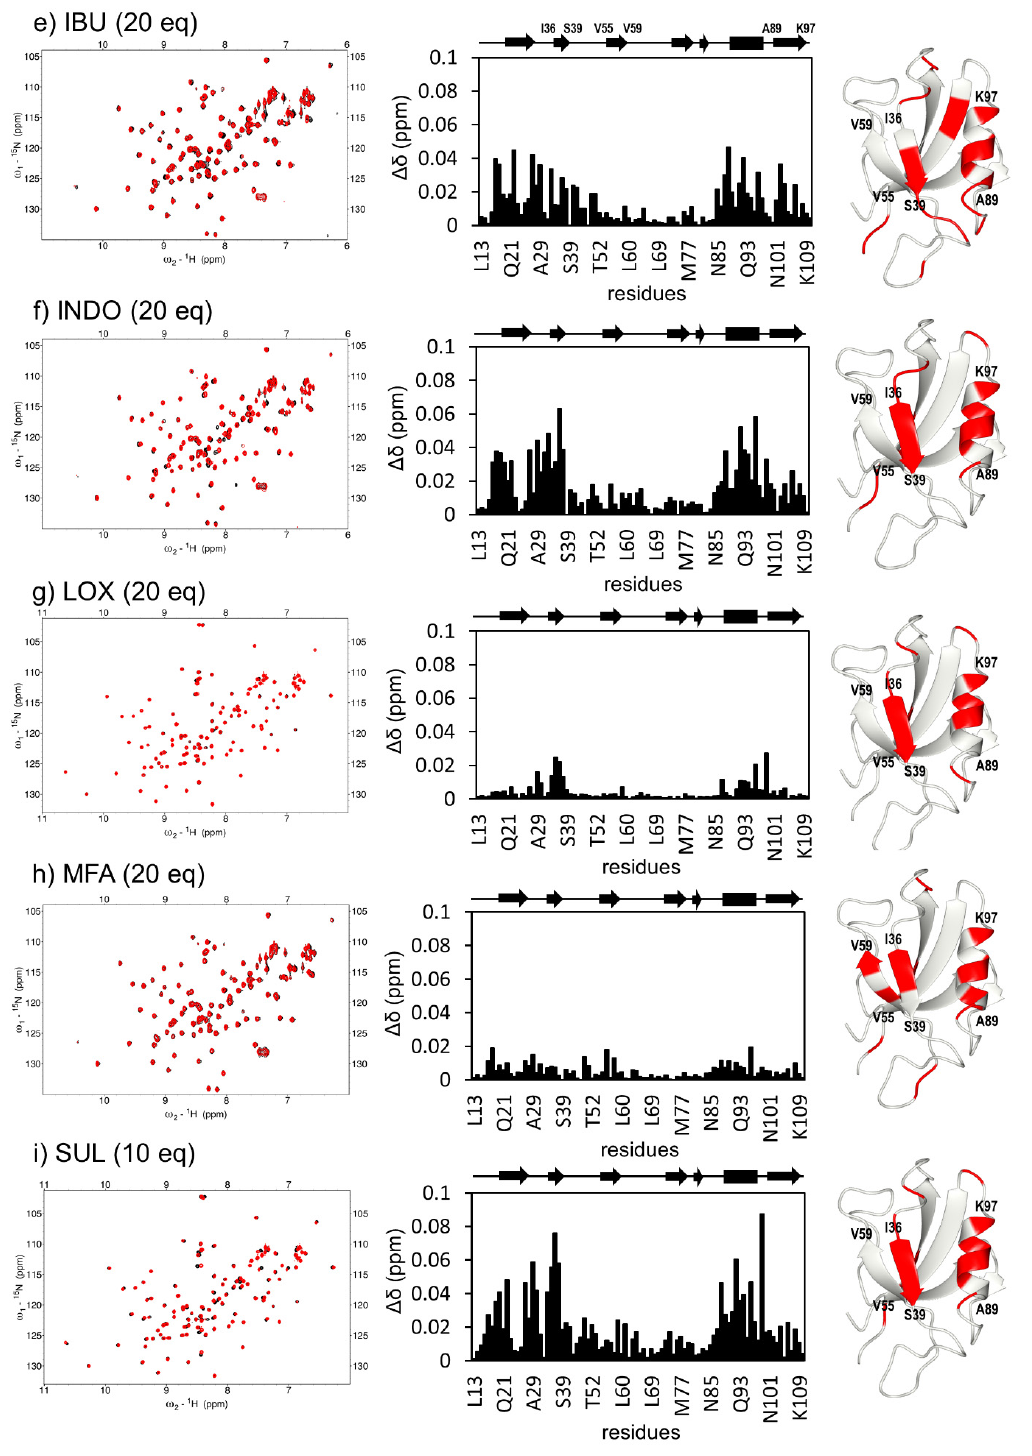
Figure 3. Interaction between ZO-1(PDZ1) and the NSAIDs. Overlaid heteronuclear single quantum coherence (HSQC) spectra of 0.1 mM ZO-1(PDZ1) in the absence (black) and presence of NSAIDs of the indicated molar equivalent (left), the combined chemical shift changes plotted versus the residues of ZO-1(PDZ1) (middle), and resonances representing residues with larger chemical shift changes than the threshold values are mapped onto the ribbon model of mouse ZO-1(PDZ1) (PDB: 2H3M) (right). ( a ) ASA (20 eq, 2.0 mM); ( b ) ACF (10 eq, 1.0 mM); ( c ) DCF (20 eq); ( d ) FFA (20 eq); ( e ) IBU (20 eq); ( f ) INDO (20 eq); ( g ) LOX (20 eq), ( h ) MFA (20 eq), and ( i ) SUL (10